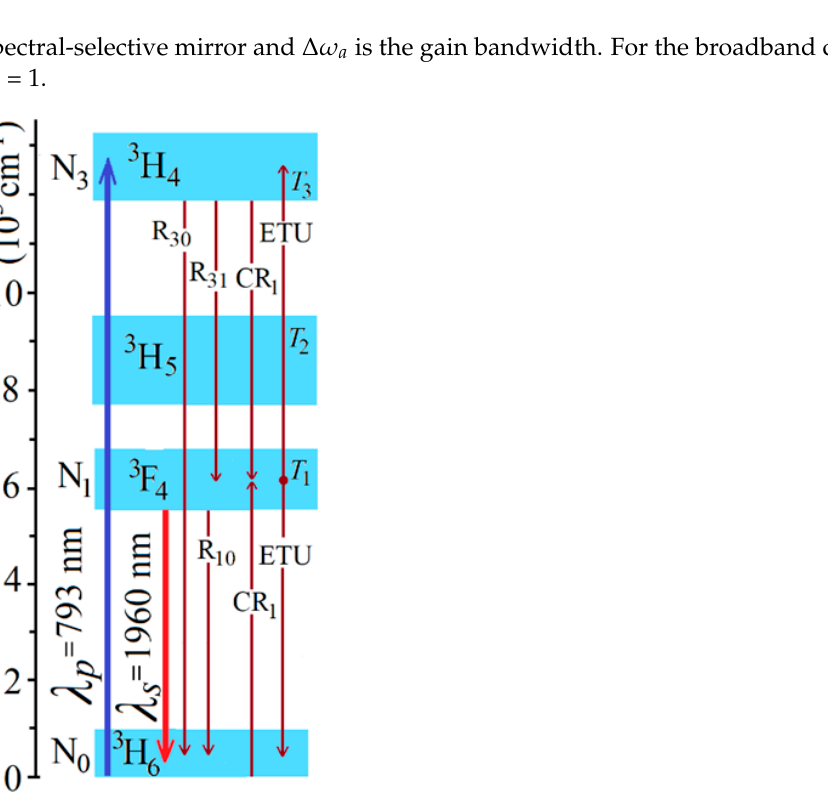
Figure 2. The scheme of lower states of Tm 3+ ions and the most important processes in the laser. It is appropriate to make the following remark on the numerical model